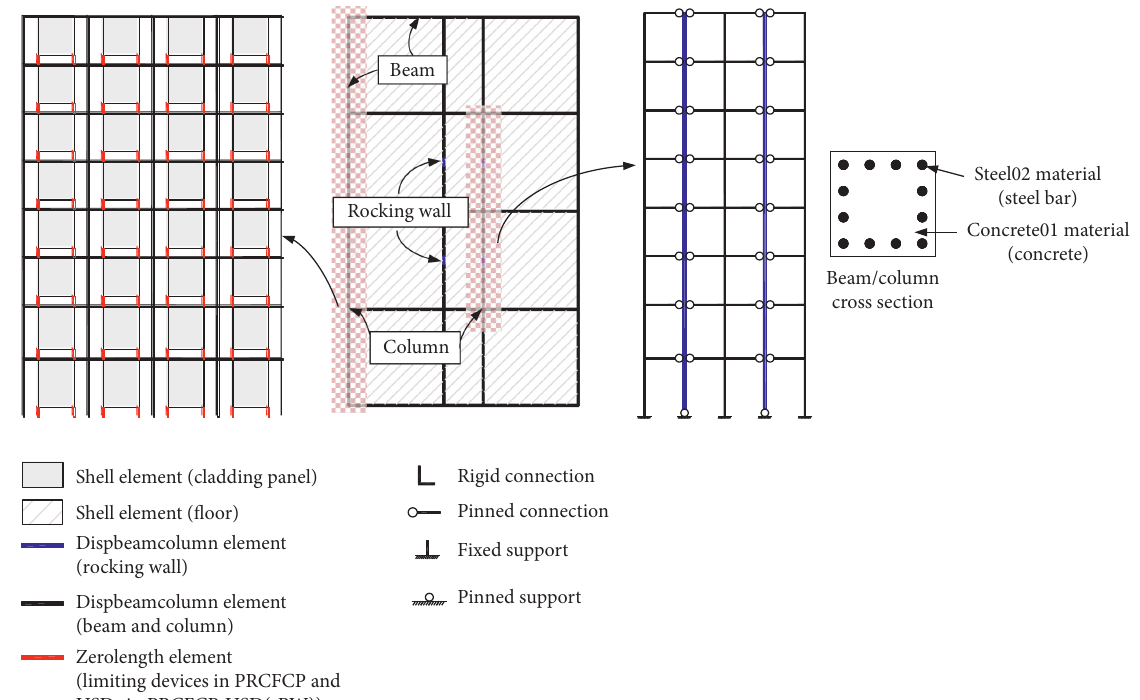
Figure 5: Numerical models used in this